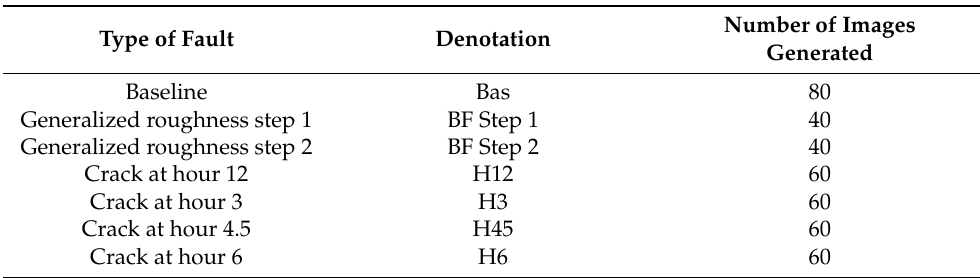
Table 4. Denotation and number of images generated for each faulty condition (in the Denotation column, BF means Bearing